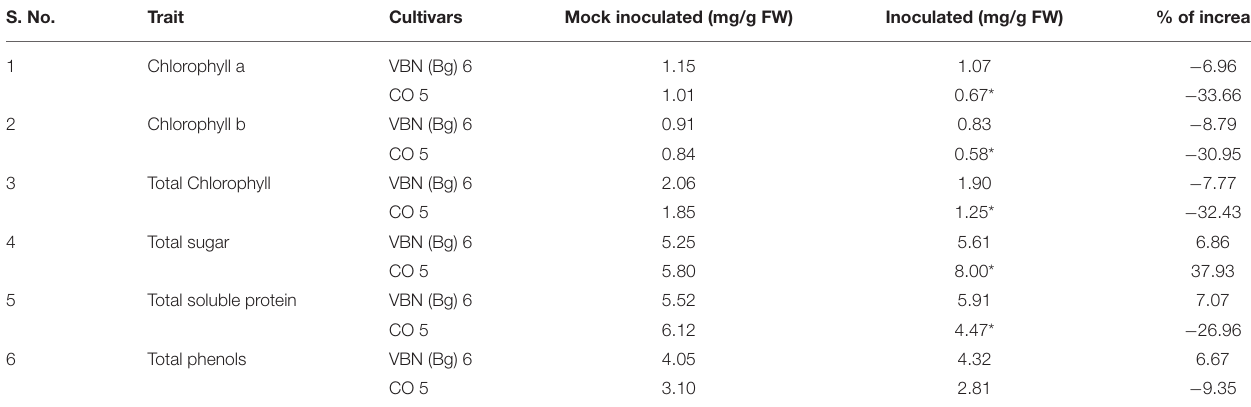
TABLE 2 | Differential response of VBN (Bg) 6 and CO 5 to urdbean leaf crinkle virus infection. S. No. Trait Cultivars Mock inoculated (mg/g FW) Inoculated (mg/g FW) % of increase